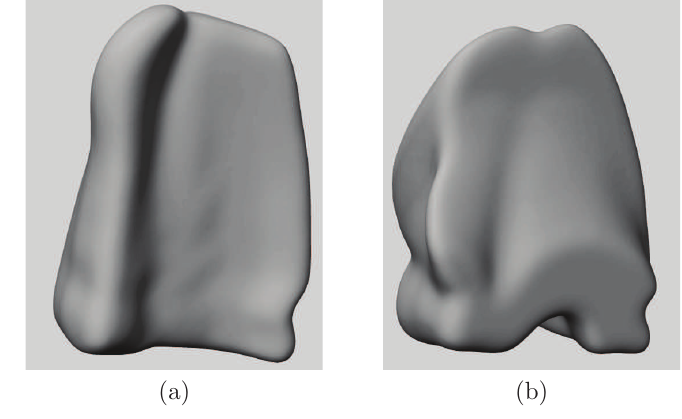
Figure 6. Two similar surfaces reconstructed from the same set of 3 contours by “pulling” two different contours: along x axis (a), along y axis (b).